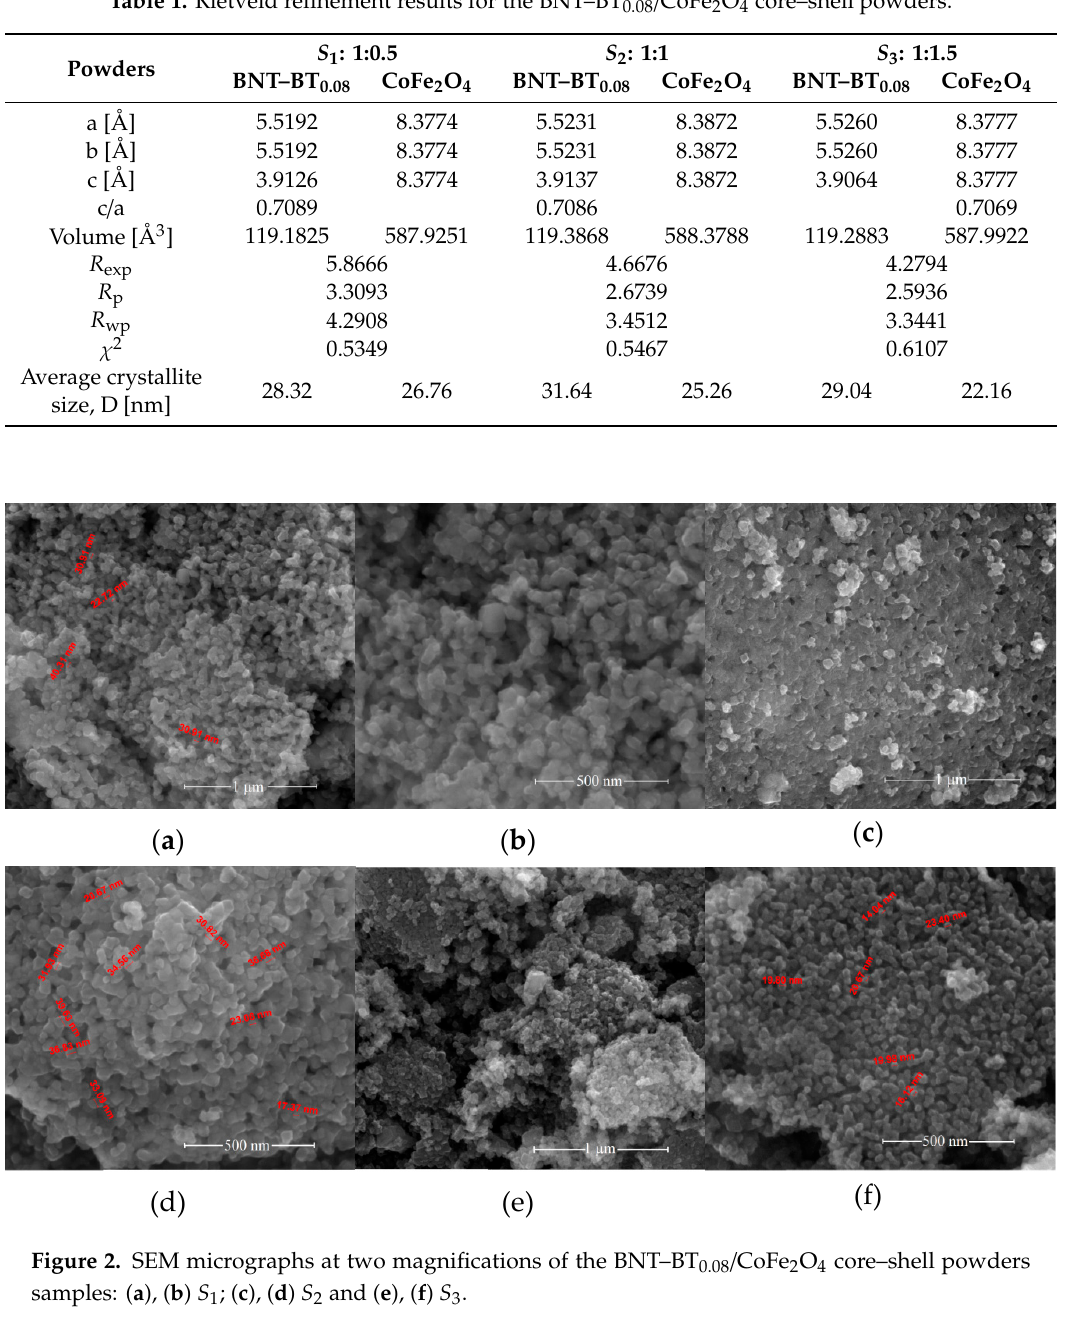
Table 1. Rietveld refinement results for the BNT–BT 0.08 / CoFe 2 O 4 core–shell powders.